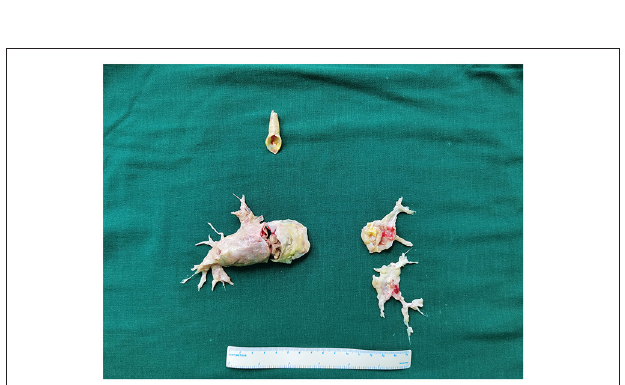
FIGURE 2 | The old thrombus and fibrotic intima were entirely